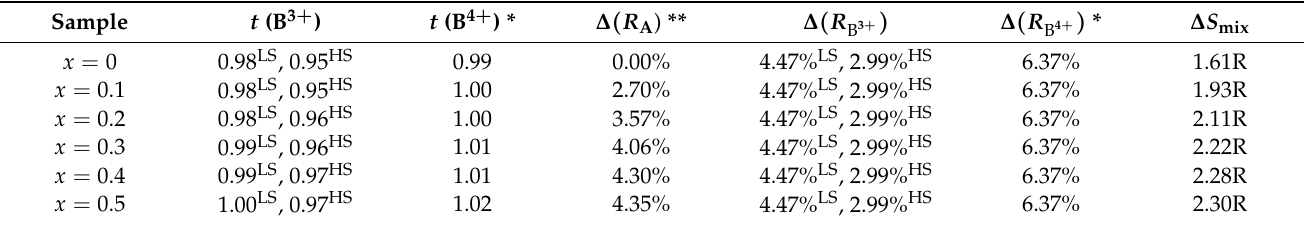
Table A2. Goldschimdt tolerance factor t , size difference of A-site cations ∆ ( R A ) , size difference of B-site cations ∆ ( R B ) , and mixed entropy ∆ S mix of Pr 1– x Sr x (Cr,Mn,Fe,Co,Ni)O 3– δ ( x = 0–0.5). LS and HS stand for low spin and high spin, respectively.